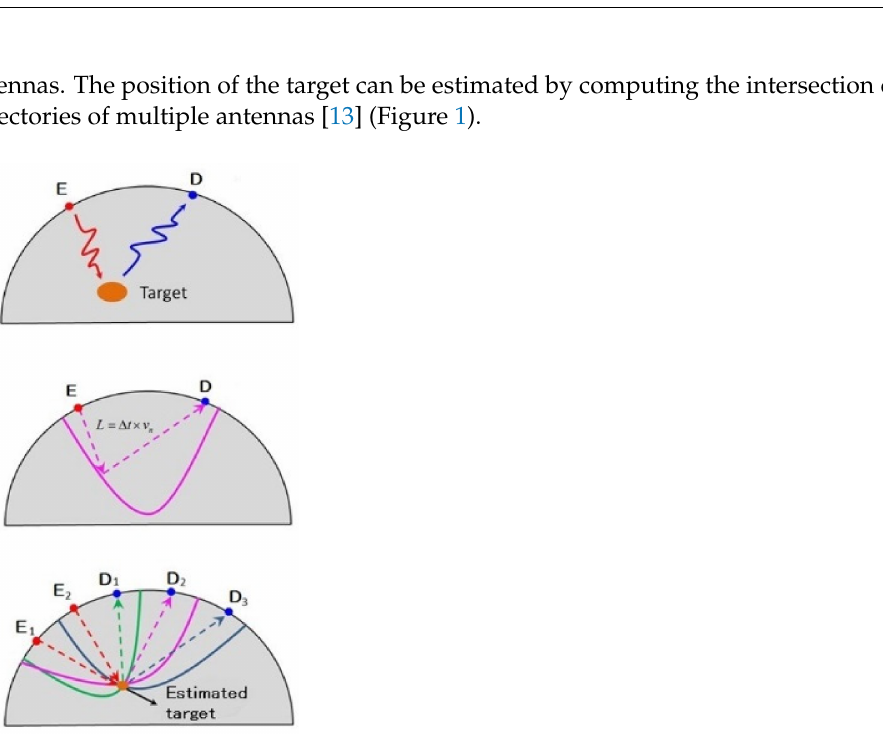
Figure 1. Principle of microwave radar-based breast imaging technology. Microwave radar-based breast imaging technology utilizes the principle of radar, in which radio waves reflect at the interface between target and normal tissues using transmit antenna D and receive antenna E, which have different permittivities ( a ). By calculating the time of flight between the transmitting and receiving antennas, we can infer a target on an elliptical trajectory focusing on these two antennas ( b ). The position of the target can be estimated by computing the intersection of the trajectories of multiple antennas ( c